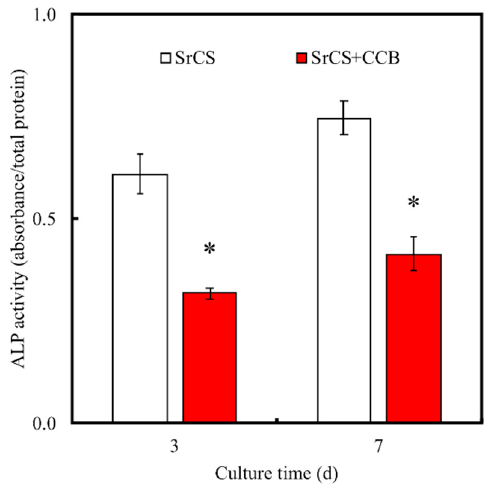
Figure 6. ALP profile of the WJMSCs cultured on the 3D-printed SrCS scaffolds in osteogenic differentiation medium without/with CCB. “*” indicates a significant difference ( p < 0.05) when compared to SrCS.